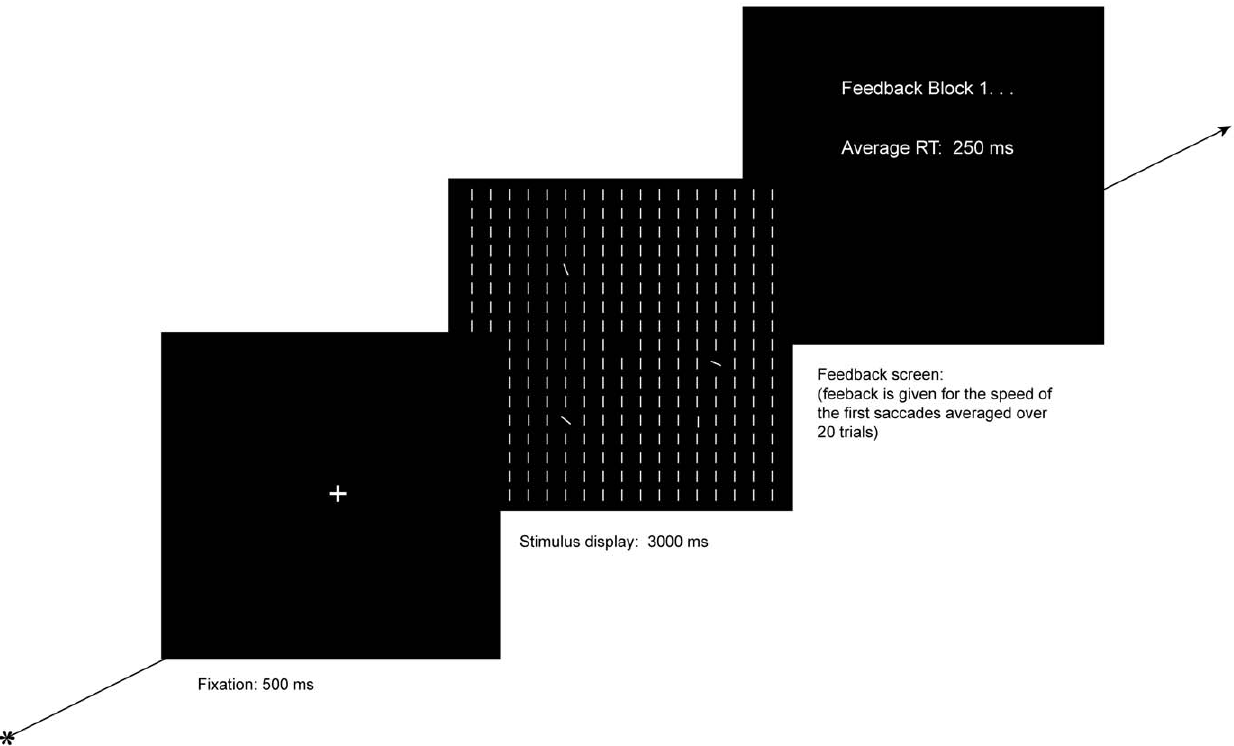
Figure 1. A typical trial sequence in Experiment 1. Prior to each trial, participants maintained fixated on a centrally presented disk until a stable fixation was detected. Upon depression of the spacebar, a drift correction was applied and a trial was initiated with the presentation of a centrally presented fixation cross. Following 500 ms, the fixation cross was replaced by the search display, which was presented for 3000 ms. Following each block, feedback regarding the speed of participants’ initial saccade was provided and participants were given the opportunity to take a short break.